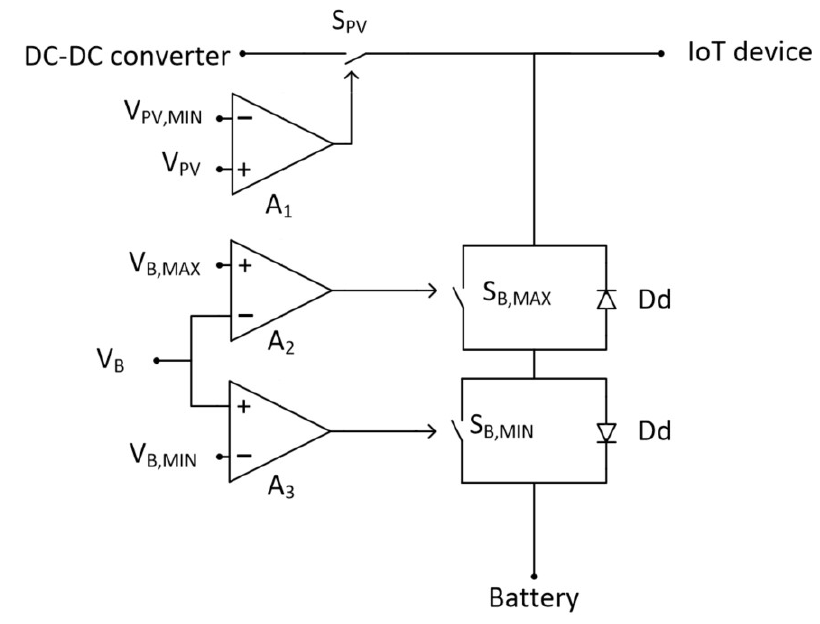
Figure 4. Charging Management System circuit.